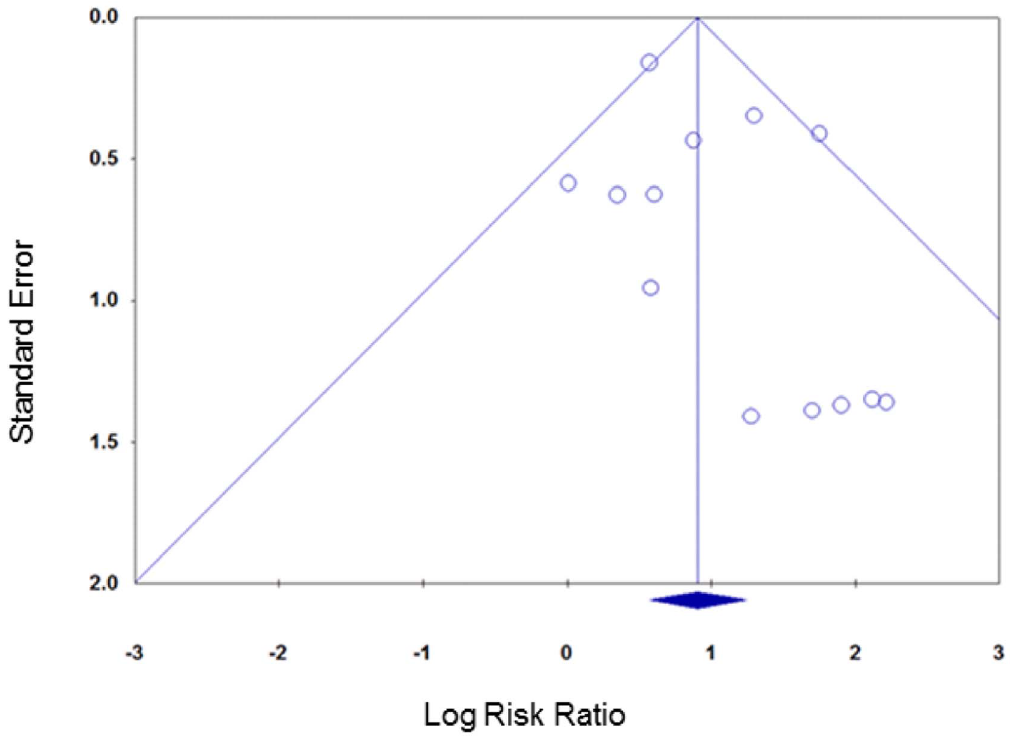
Figure 9. Contour enhanced funnel plot, smoking cessation (follow-up # six months).